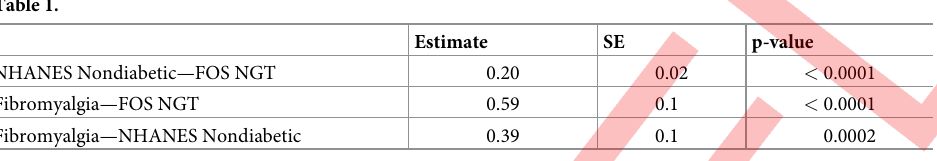
Table 1. NHANES Nondiabetic—FOS NGT Fibromyalgia—NHANES Nondiabetic Differences in HbA1c among groups, per Tukey-adjusted differences from regression model.